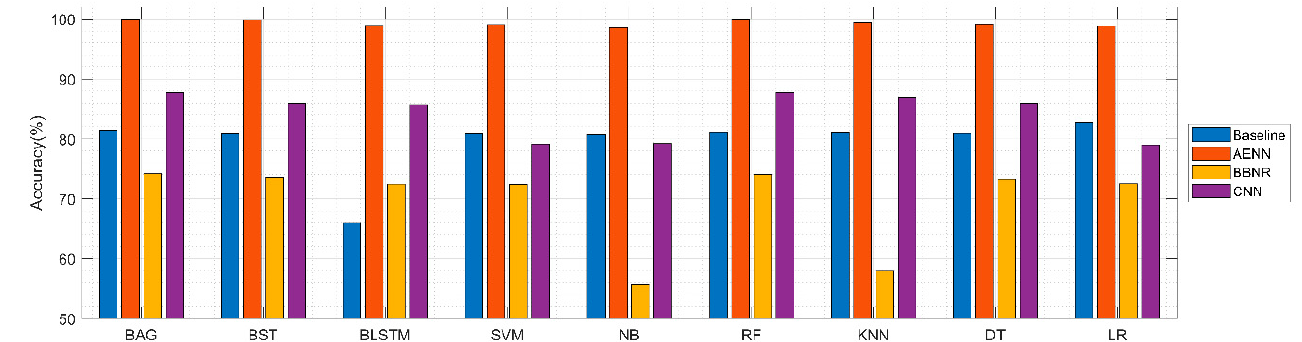
Figure 1. Performance of baseline (no filtering used) and filtering methods (AENN, BBNR, and CNN).